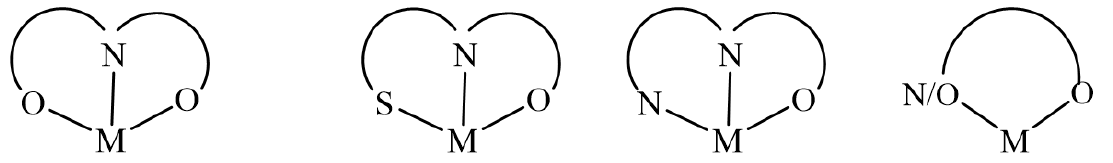
Figure 14. Coordination modes for the coumarins complexes.